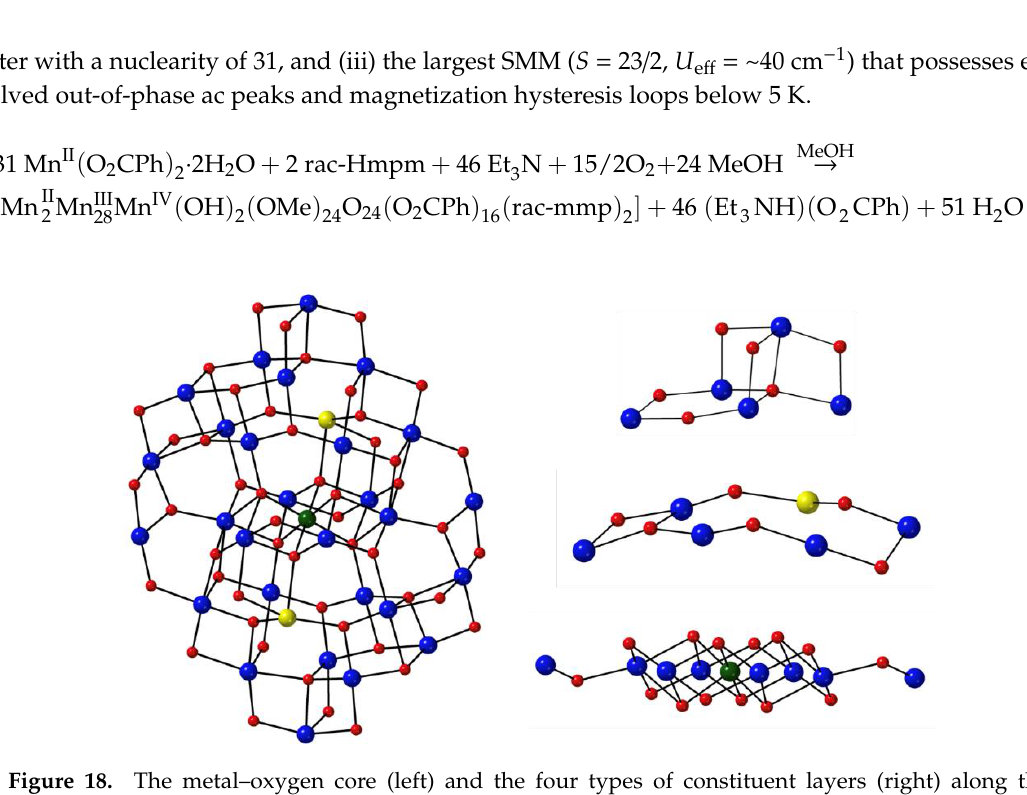
Figure 19. 1,3-propanediol (H 2 pd; R = R’ = H) and its derivatives.